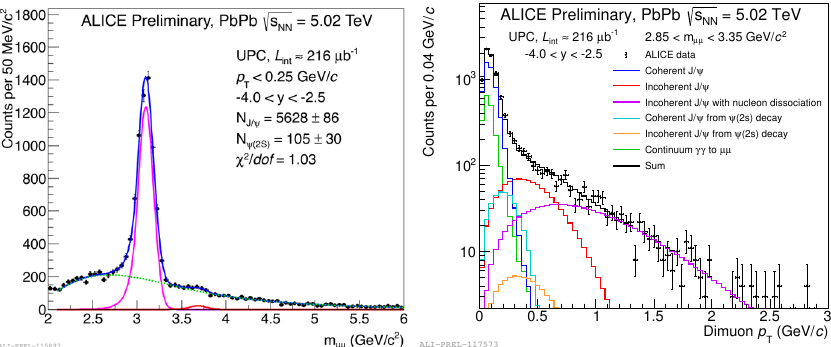
Figure 5. Left: invariant mass distribution for unlike-sign dimuons with pair p T < 0 . 25 GeV / c and rapidity − 4 . 0 < y < − 2 . 5 in ultra-peripheral Pb–Pb collisions at momentum distribution for unlike-sign dimuons around J /ψ mass fitted summing six di ff erent Monte Carlo templates produced using the STARLIGHT event generator [8]